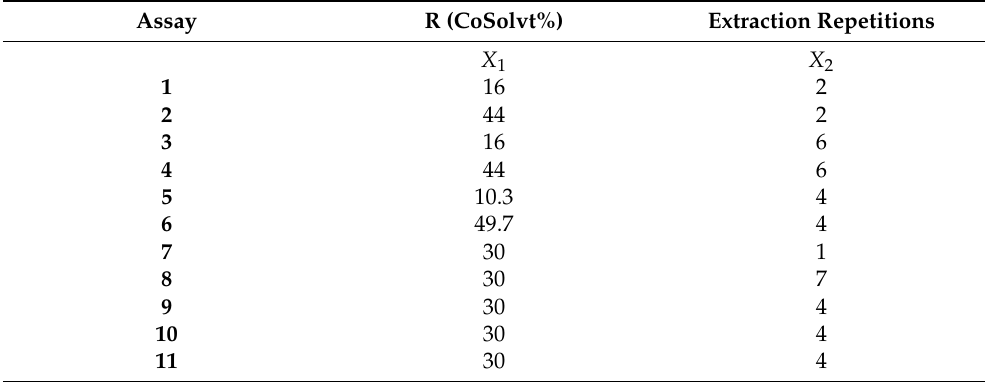
Table 3. Independent variable values used in CCRD 2 2 assays with 3 central points, used as indepen- dent variables R (CoSolvt%) and extraction